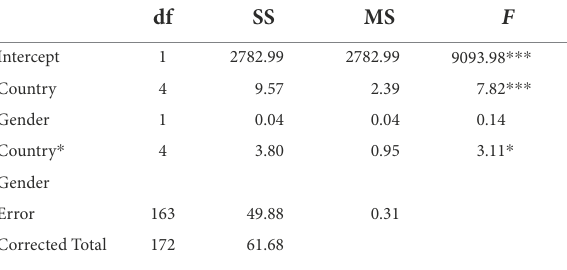
TABLE 5 Results of the two-way ANOVA of academic discipline content knowledge with variables of country and gender. df